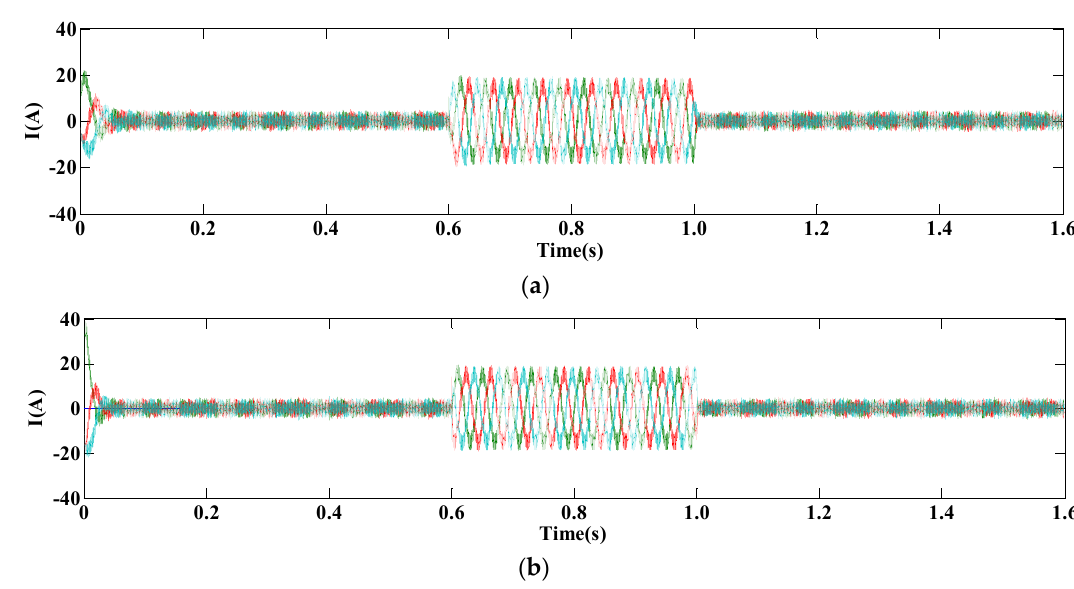
Figure 6. Speed curves under loads.